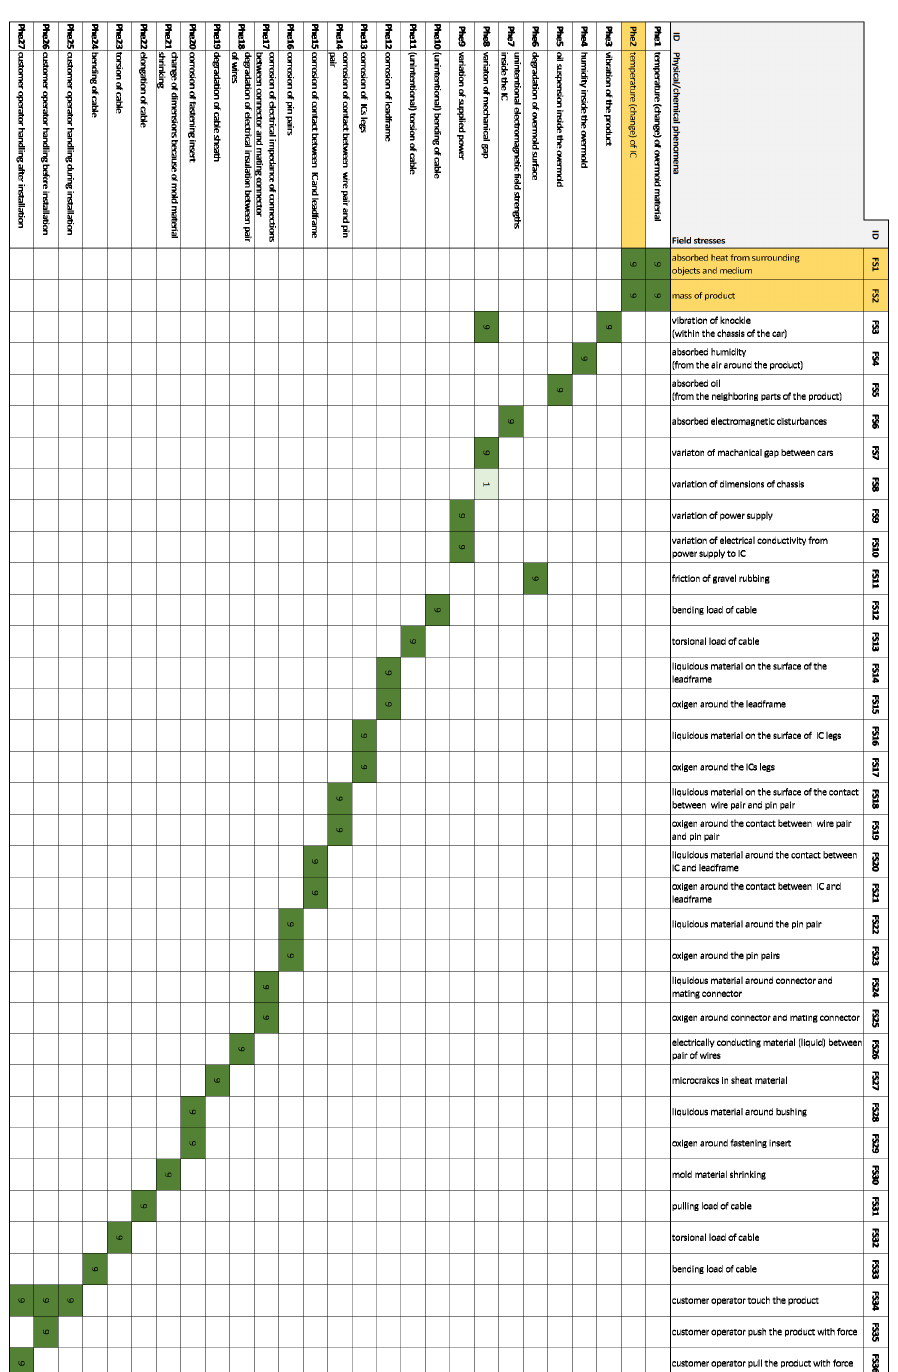
Figure 9. House of Field Stresses: this is the third House of Noises: Physical/chemical phenomena vs. Field stresses. The House of Field Stresses connects the direct causes from the House of Phenomena (output of the House of Phenomena) to its direct